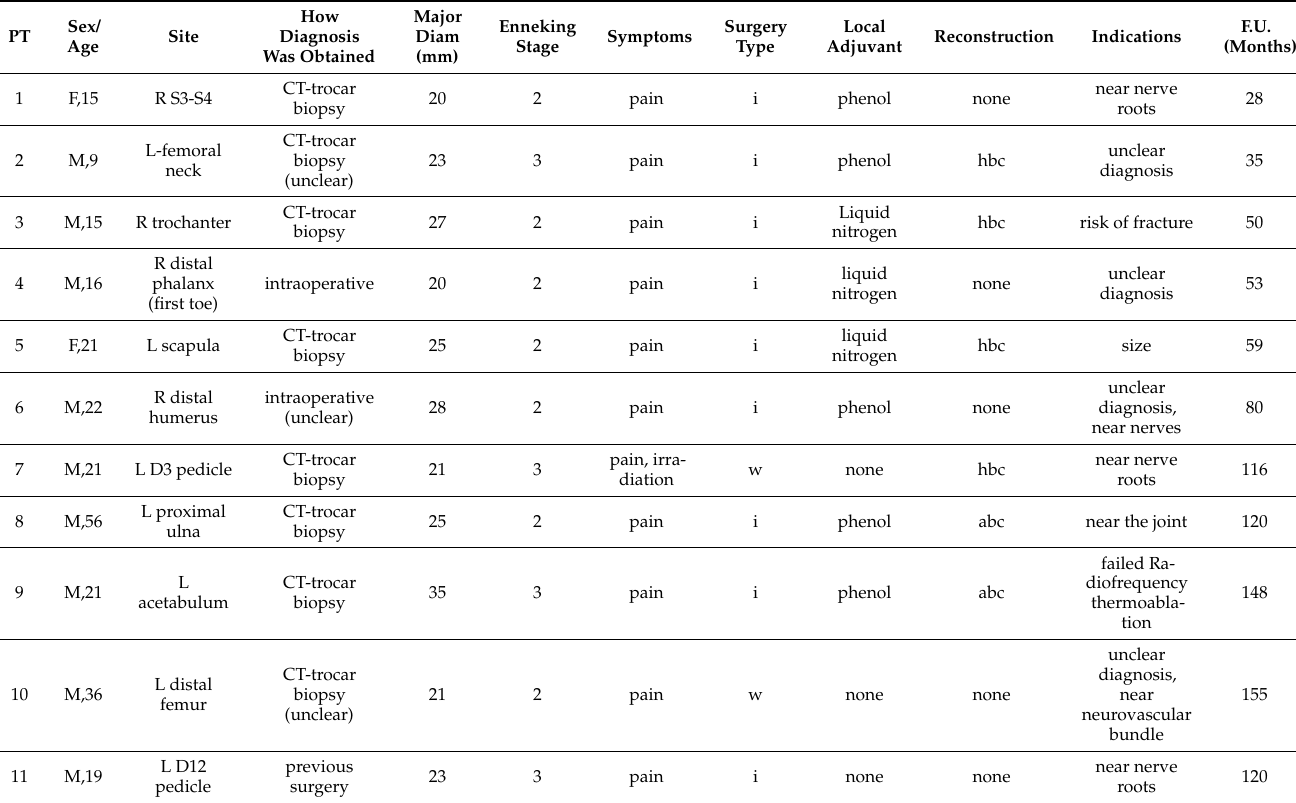
Table 1. Patients’ clinical